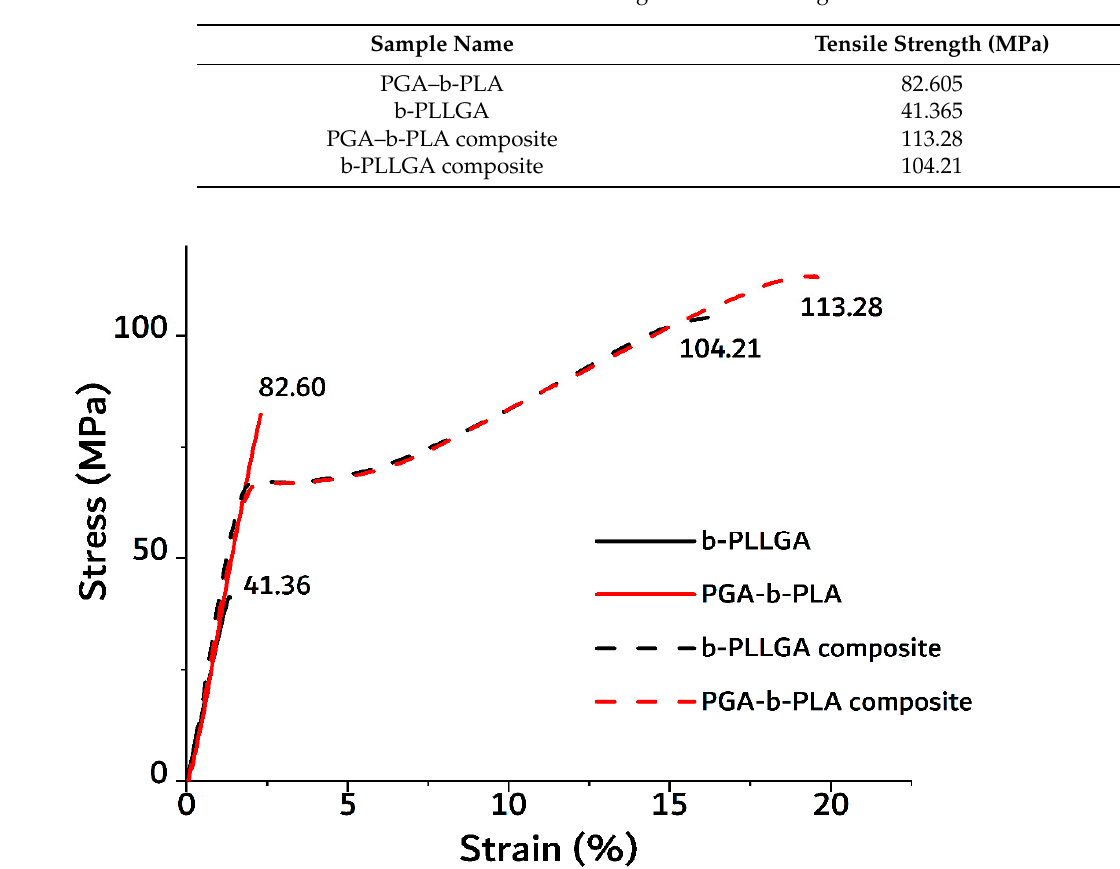
Figure 3. Tensile stress-strain curves of the PGA–b-PLA, b-PLLGA, PGA–b-PLA composite, and b-PLLGA composite.